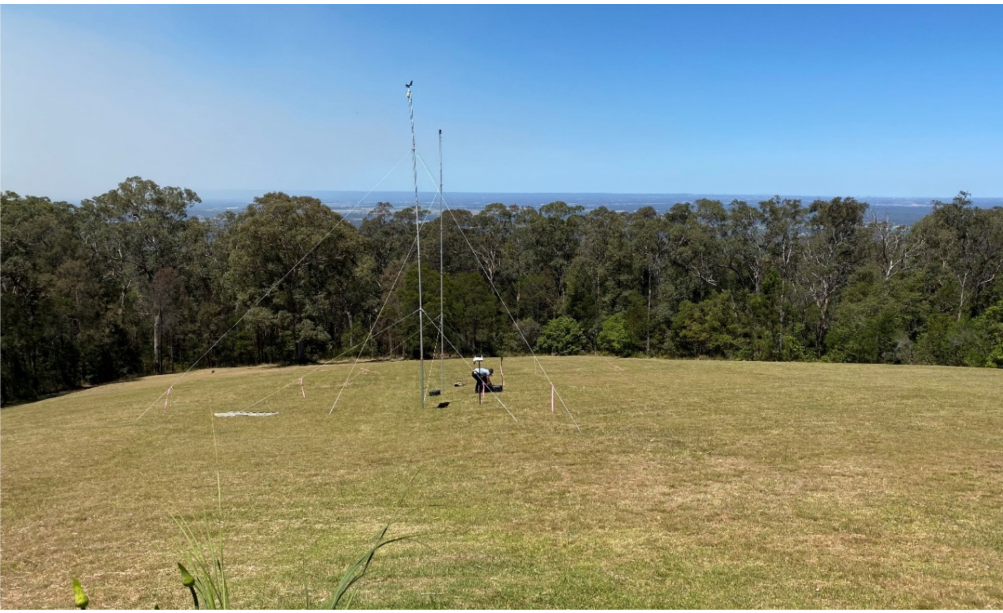
Figure 6. Center of open